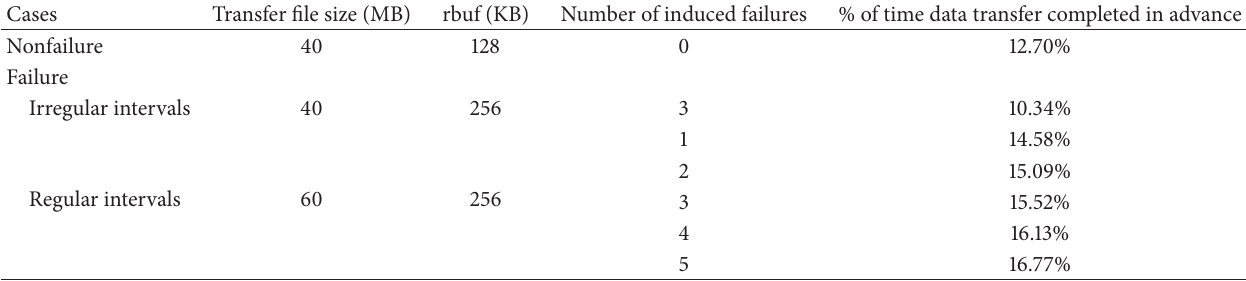
Table 3: Performance analysis for various file and buffer sizes.